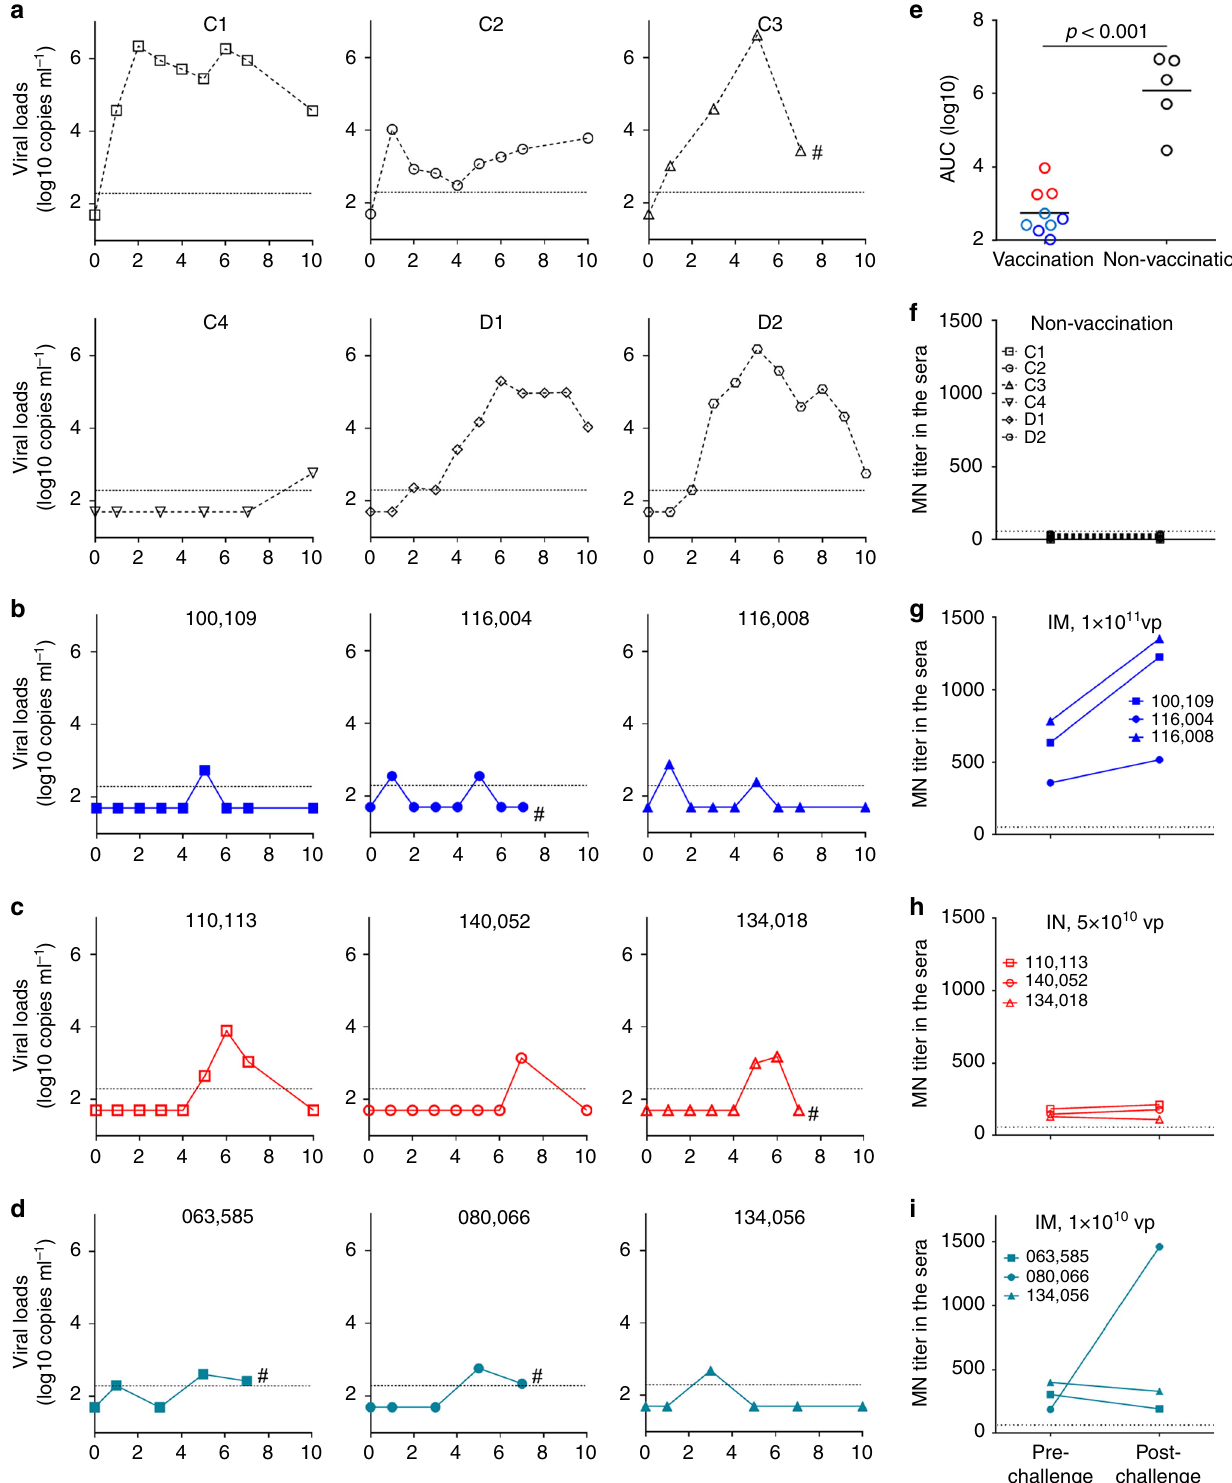
We compared the serum neutralizing antibody titers before and after the challenge by a plaque reduction neutralization test (PRNT). All non-vaccinated macaques showed no serum neutralizing activities (<1:50) against SARS-CoV-2 either before or 7 days after challenge (Fig. 4f). Before the challenge on 30 days after vaccination, three high-dose IM vaccinated macaques had serum neutralizing antibody titers with IC50 at 1:636, 1:389, and